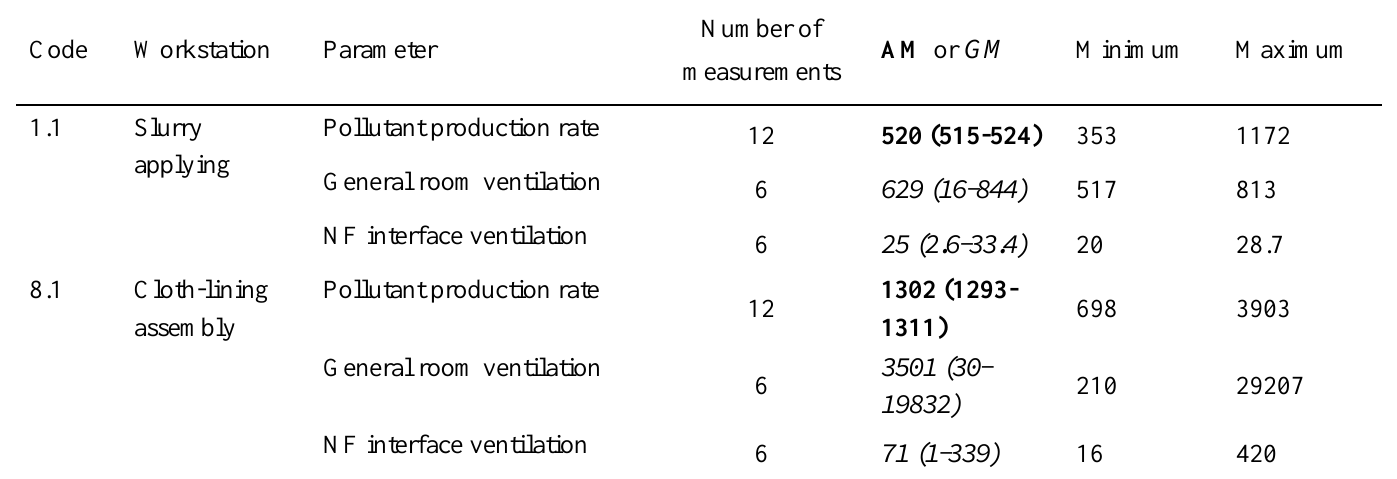
Table 1. Parameters measured in the factory (90